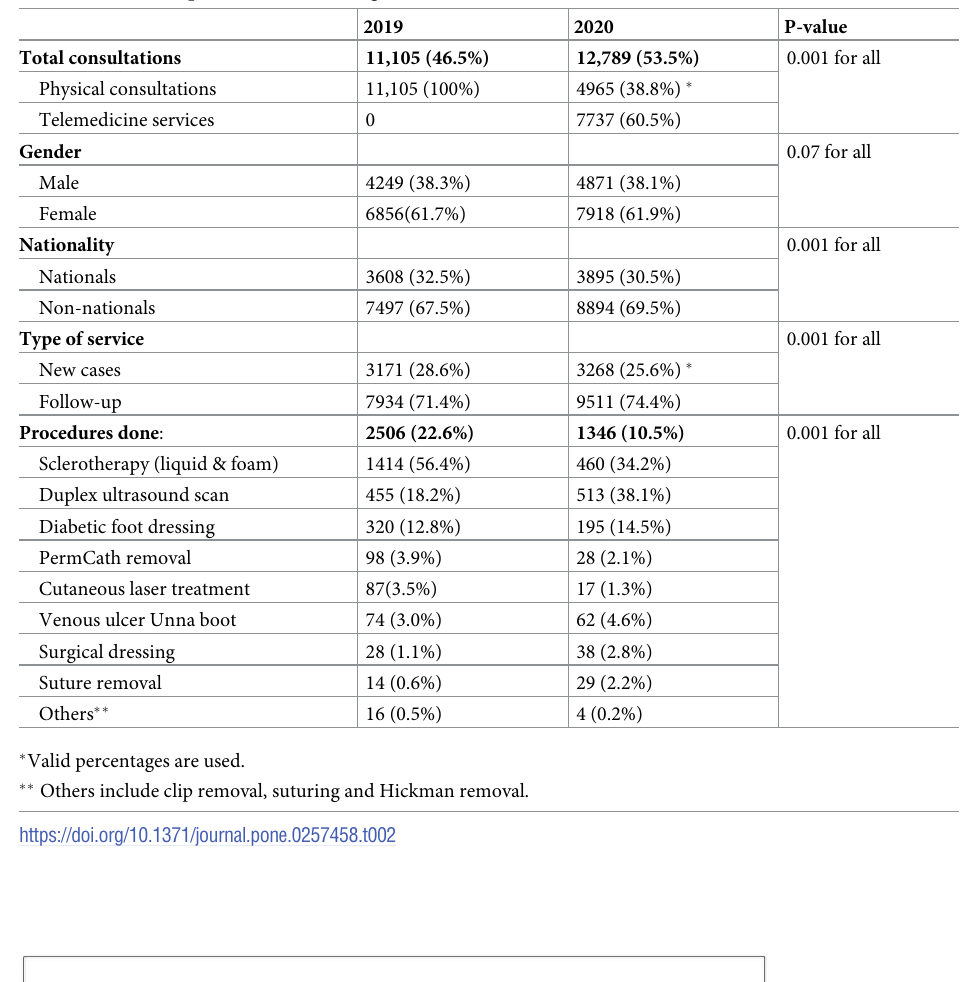
Table 2. Patients consultations, characteristics, and procedures at the vascular surgery outpatient clinic at Hamad General Hospital before and during the COVID-19 era (N = 23,984).